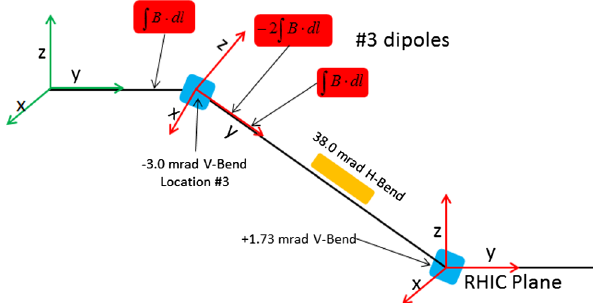
FIG. 3. The second section of the AtR line where the beam is bent simultaneously along the vertical (blue rectangles) and horizontal (yellow rectangle) planes by 3.0 and 38.0 mrad respectively. The red rectangles represent proposed dipole mag- nets which can be placed at this location along the AtR line to rotate the stable spin direction and match it to that at the RHIC injection